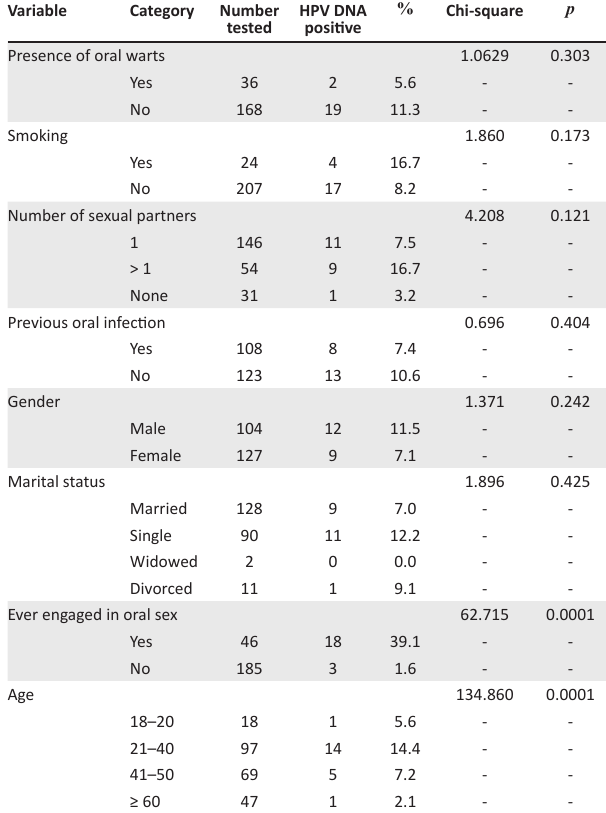
TABLE 3: Distribution of human papilloma virus infection among dental clinic attendees in Ibadan, Nigeria, January 2016 to March